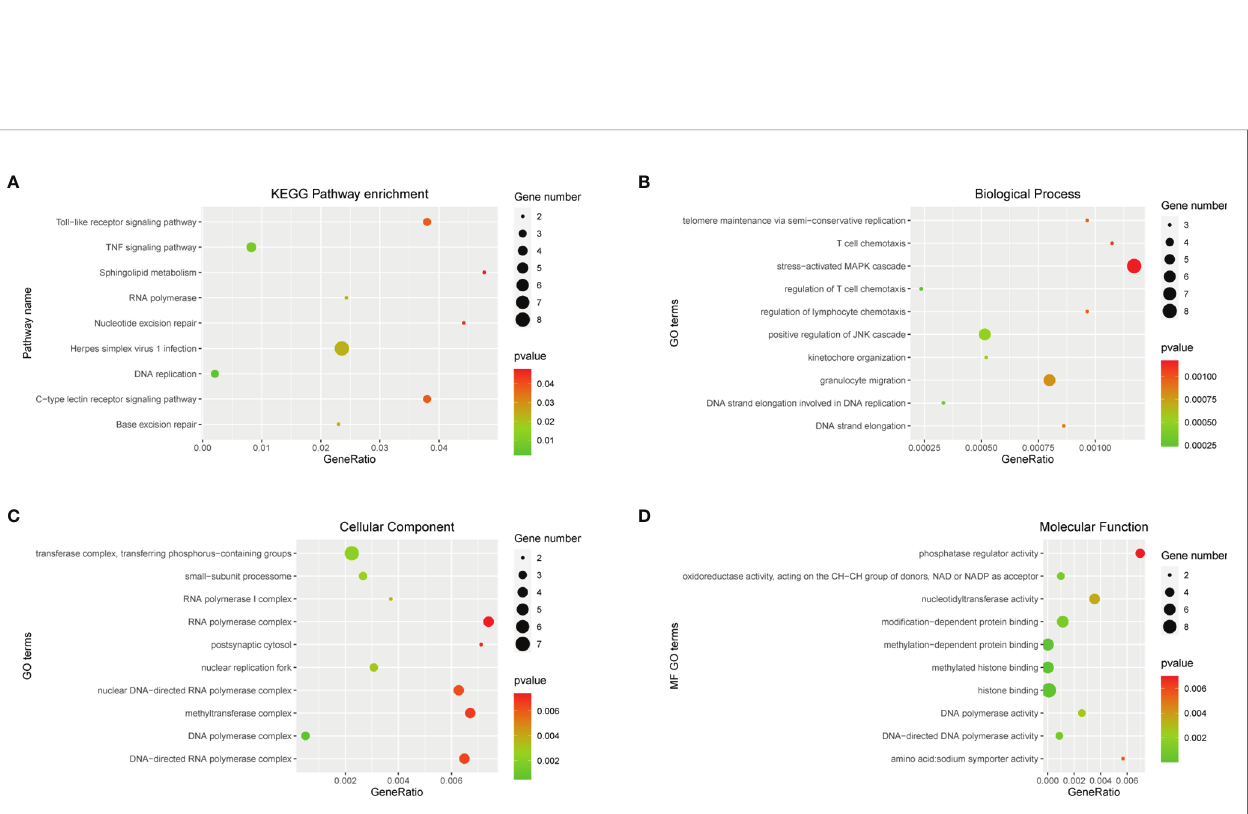
FIGURE 3 | Function enrichment analysis of mRNAs in ceRNA network. (A) KEGG enrichment analysis of mRNAs in ceRNA network. (B-D) GO enrichment analysis of mRNAs in ceRNA network including BP, CC, and MF. Gene numbers represent the number of enriched